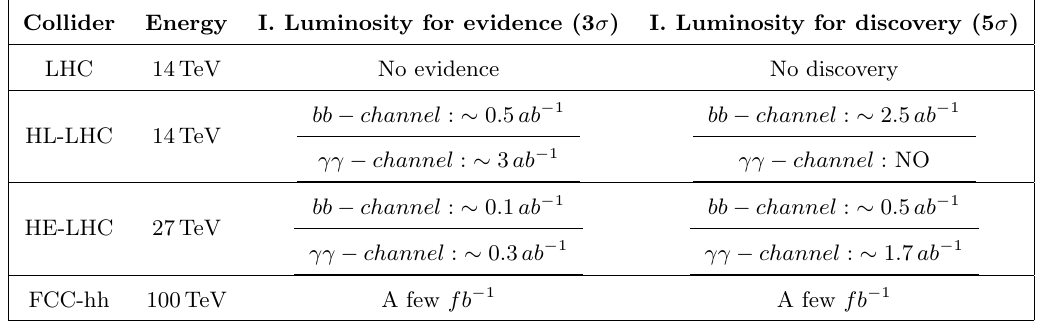
Table 3. Integrated luminosities for evidence or dicovery of the t ! ch decay at hadron colliders. photons ( (cid:13)(cid:13) (cid:0) channel ) and into two bottom quarks ( bb (cid:0) channel ). After studying the constraints on the free model parameters from the most up-to-date Higgs boson coupling and applying several kinematic cuts to the signal and SM background, we (cid:12)nd that with the integrated luminosity achieved at the LHC, 0 : 3 ab (cid:0) 1 , is not possible claim discovery for the t ! ch decay. However, in the bb (cid:0) channel , an integrated luminosity of at least (cid:24) 0 : 5 ab (cid:0) 1 is necessary to achieve a signal signi(cid:12)cance of 3 (cid:27) . On the other hand, with the forthcoming HL-LHC, once it achieves an integrated luminosity of (cid:24) 2 : 5 ab (cid:0) 1 ( (cid:24) 3 ab (cid:0) 1 ), discovery (ev- idence) in the bb (cid:0) channel ( (cid:13)(cid:13) (cid:0) channel ) could be claimed. More favorable results emerge for the HE-LHC since with an integrated luminosity of (cid:24) 0 : 5 ab (cid:0) 1 ( (cid:24) 1 : 7 ab (cid:0) 1 ), discovery of the t ! ch decay in the bb (cid:0) channel ( (cid:13)(cid:13) (cid:0) channel ) will be announced. With these